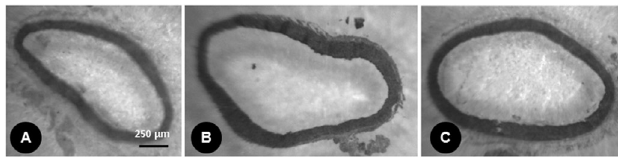
Figure 7. Transverse section of collagen fibres of a MA aorta (A), of an OC aorta (B) and of an OT aorta (C). The constituent fibrils (arrows) in (B) are of significantly larger diameter than those shown in (A) and (C). S-Smooth muscle cell; i-interstitium; e-elastic